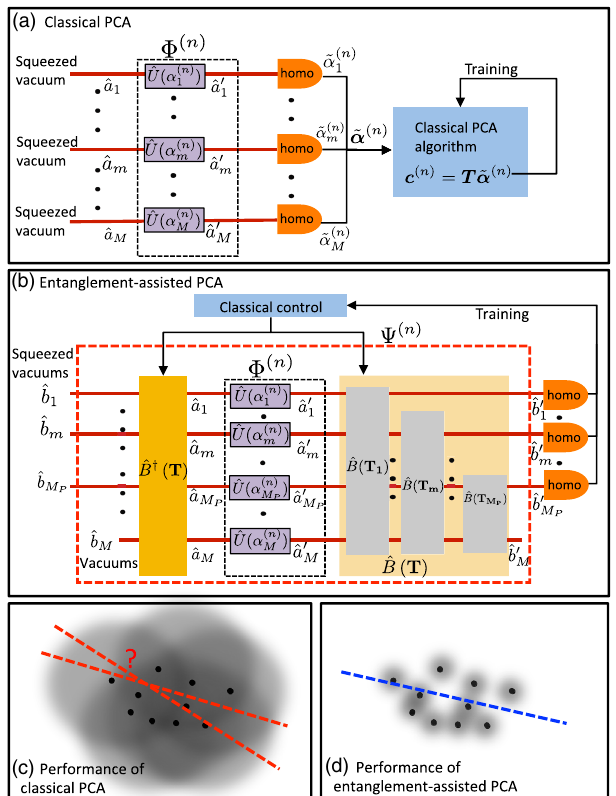
FIG. 5. (a) Schematic of the classical PCA scheme. Separable probes are used to obtain a full noisy classical description ˜ α ð n Þ of the unknown channel Φ ð n Þ . Then, a classical PCA algorithm finishes the compression task. (b) Schematic of the entanglement- assisted PCA. The original channel Φ ð n Þ with dimension M is reduced to a new channel Ψ ð n Þ with dimension M dimension reduction is carried out by two variational circuits, ˆ B ˆ B ð T Þ † and ð T Þ , trained by a classical algorithm. The training process requires M squeezed vacuum states at the input modes P ˆ ˆ b b 1 to and M homodyne measurements at the output modes M P P ˆ ˆ b 0 b 0 1 to . (c,d) illustration of the performance contrast between M P the entanglement-assisted PCA and classical PCA in the param- eter space. The blur is due to measurement uncertainties. While the measurement uncertainties prevent the classical PCA from finding the principal axis, the entanglement-assisted PCA pre- cisely identifies the principal axis.